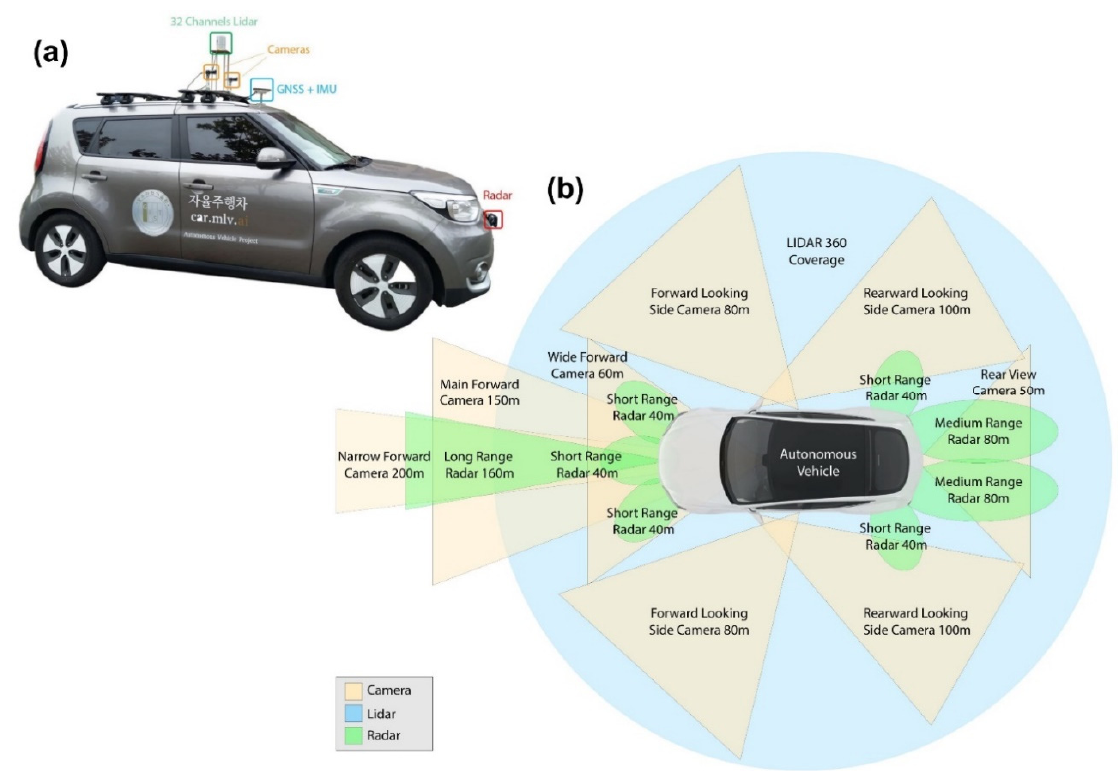
Figure 8. ( a ) Positions of the sensors installed on an autonomous vehicle [136]; ( b ) Coverage and maximum range of various sensors for environment perception in autonomous vehicles [137].